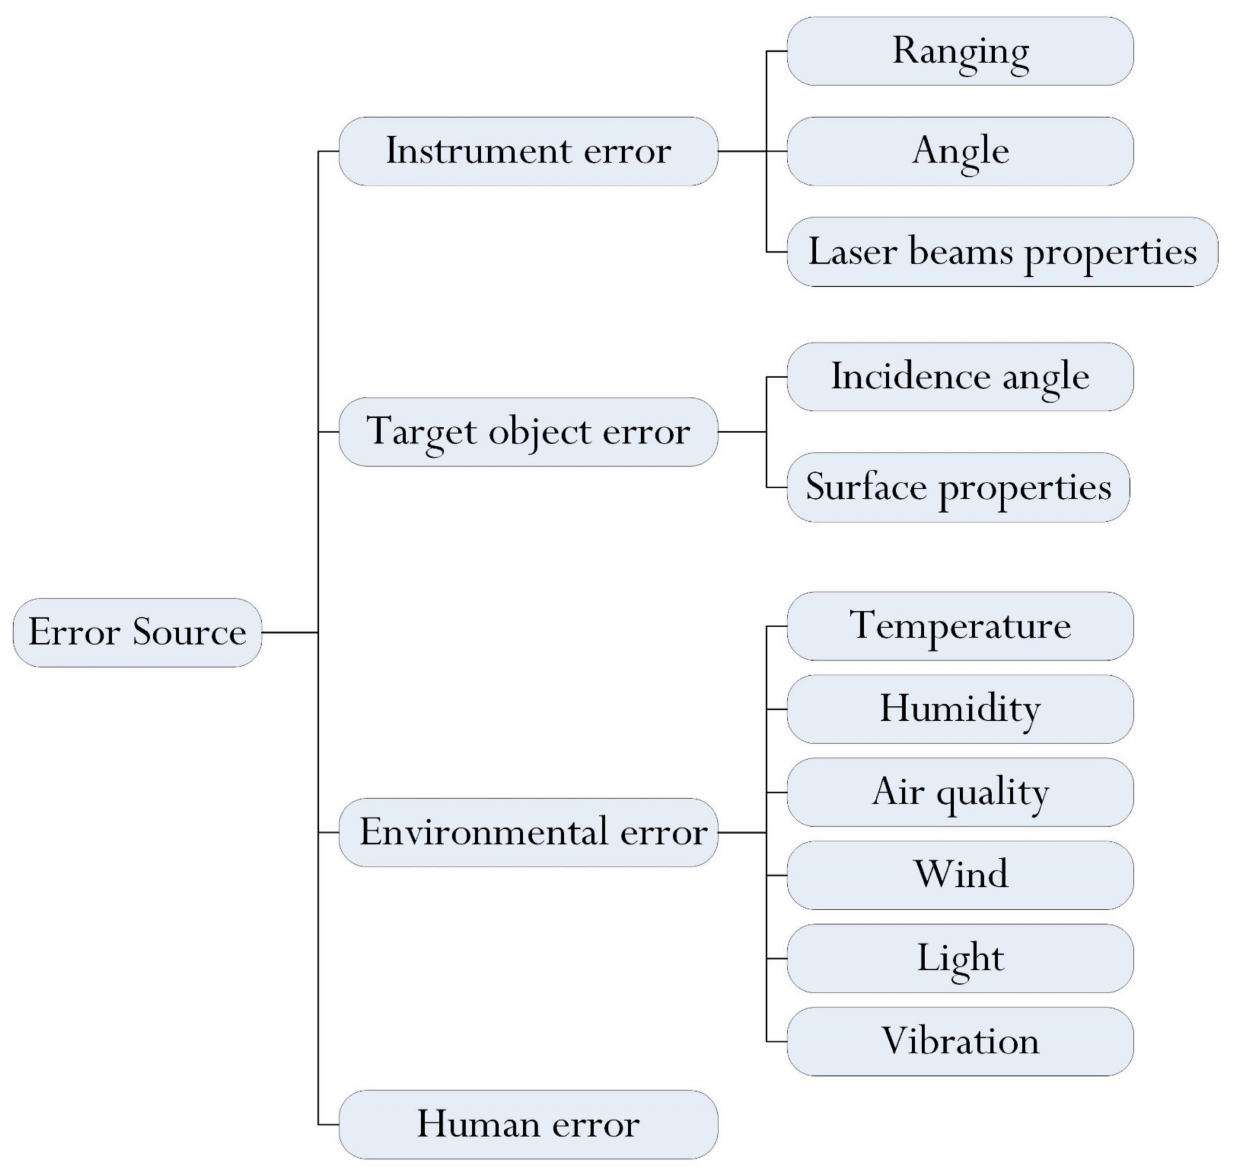
Figure 10. The classification of error